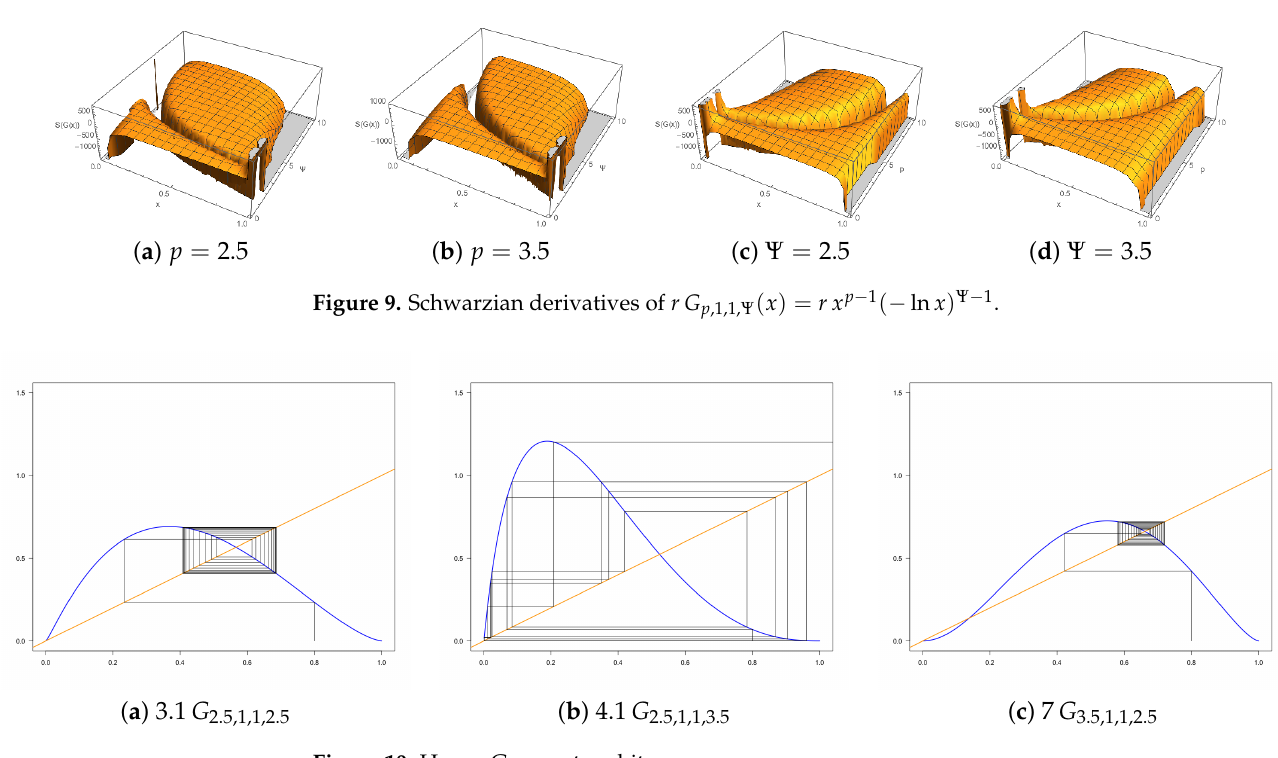
Figure 10. Hyper-Gompertz orbits.